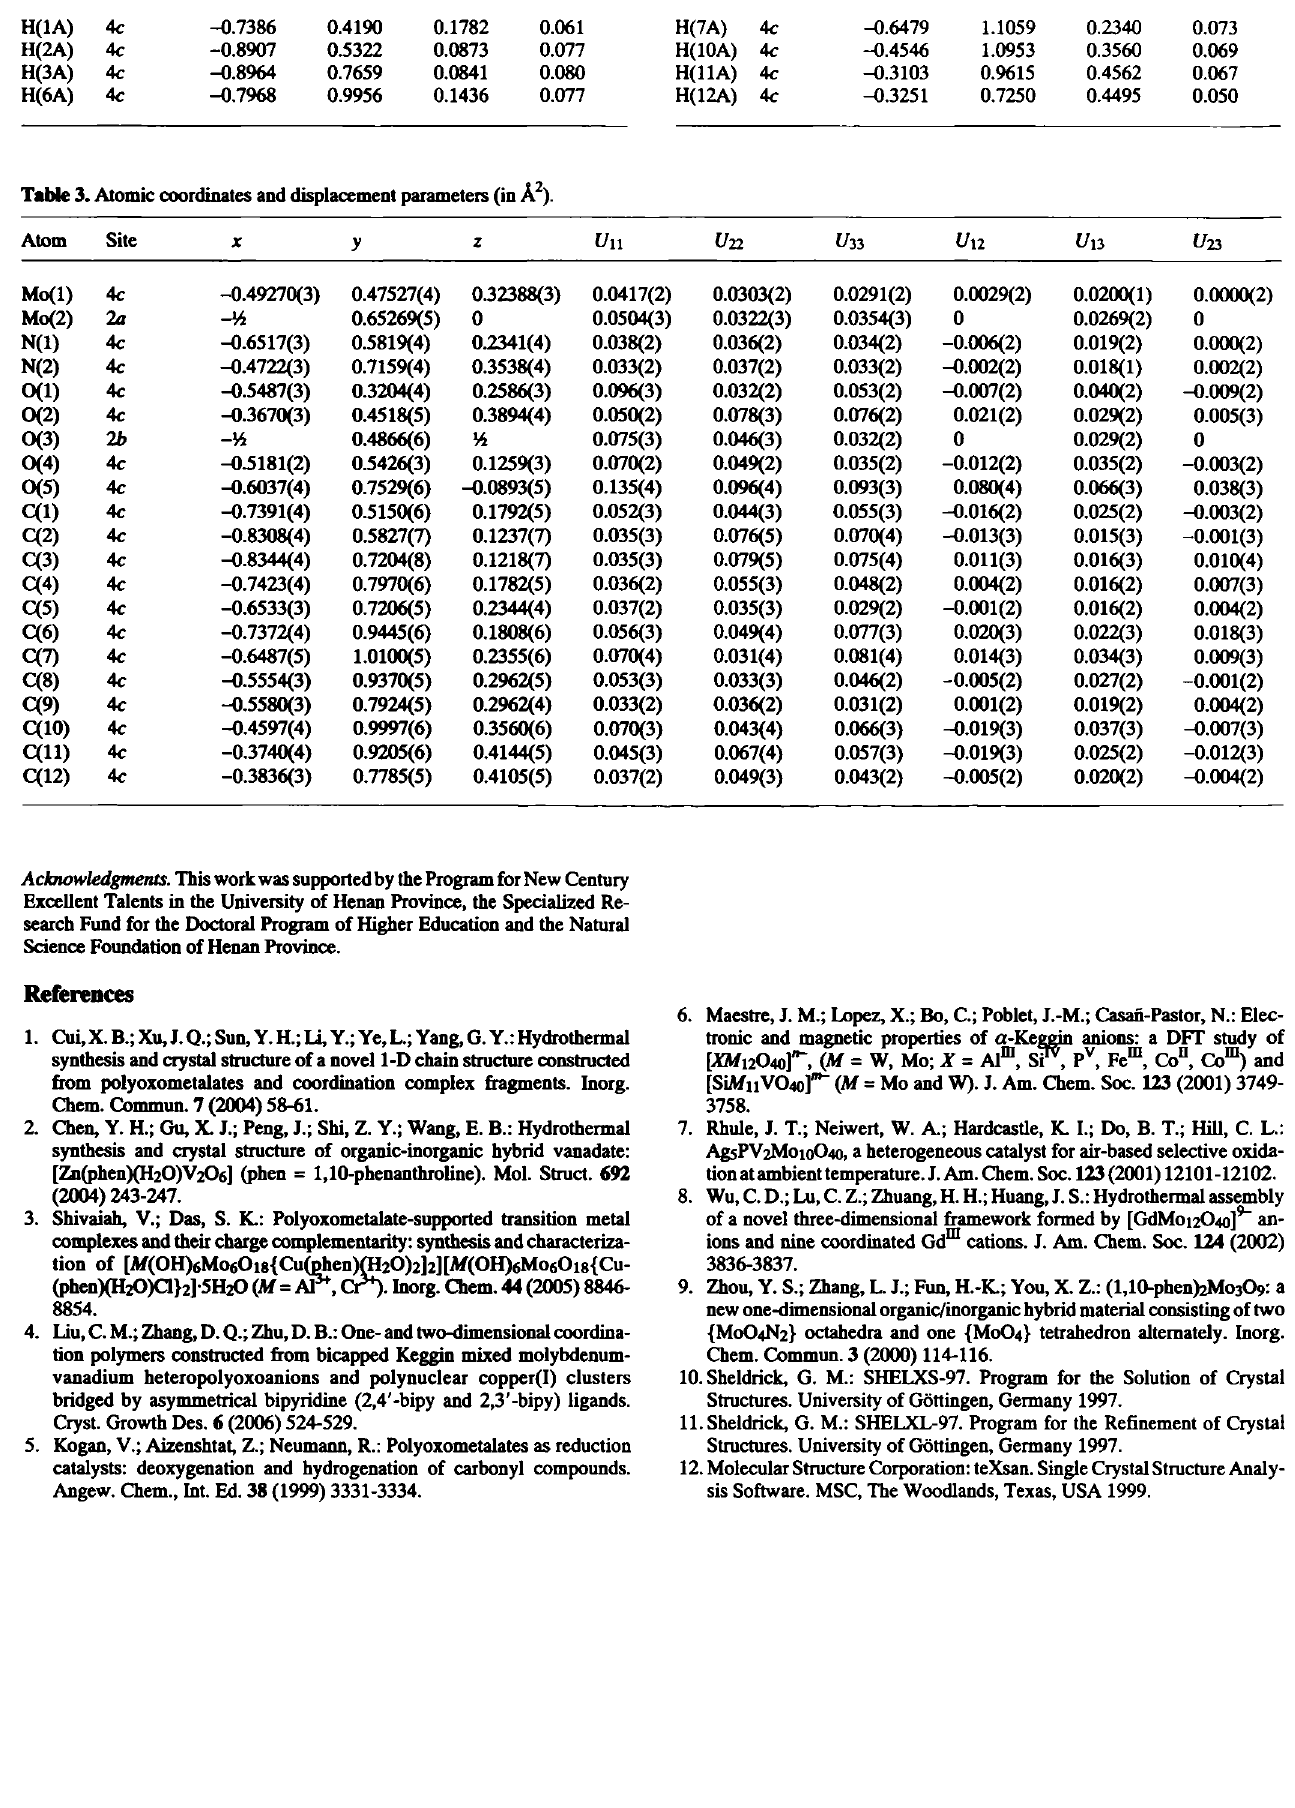
Table 3. Atomic coordinates and displacement parameters (in Ä 2